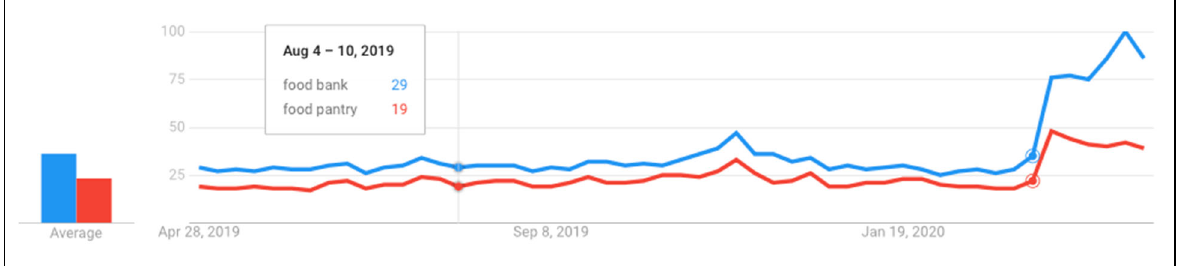
Source: Google Trends, April 27, 2020; circles to the right show week of March 8–14,